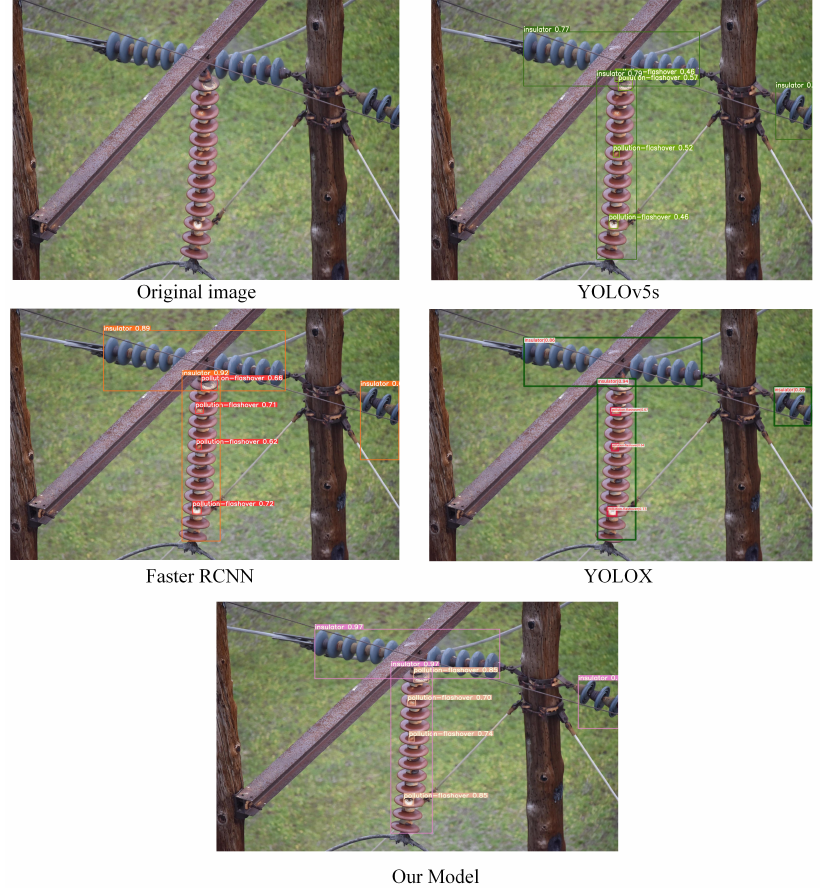
Figure 16. Detection results after the target are